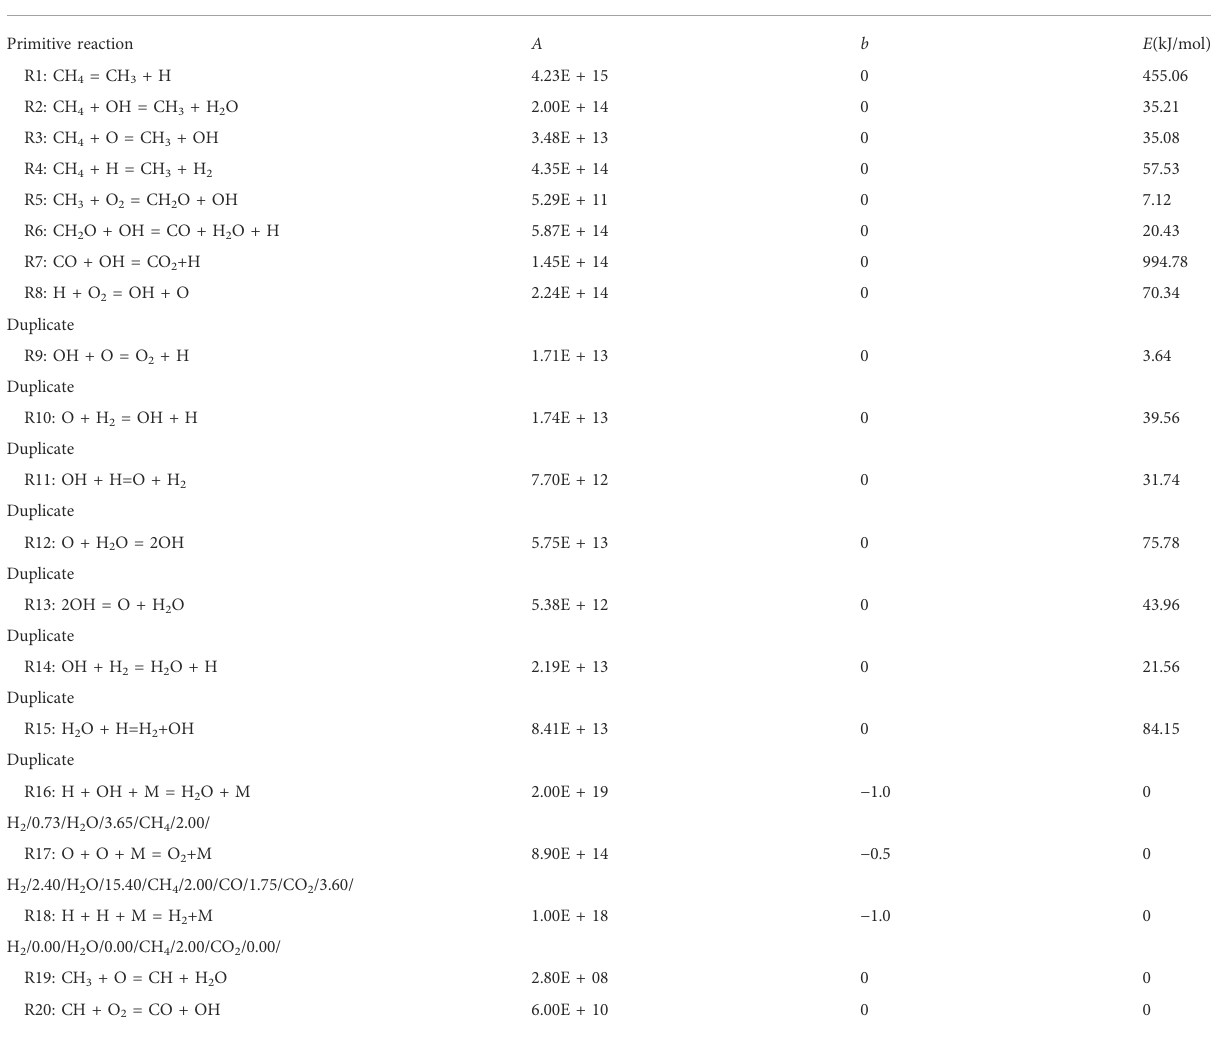
TABLE 1 Chemical kinetics mechanism of